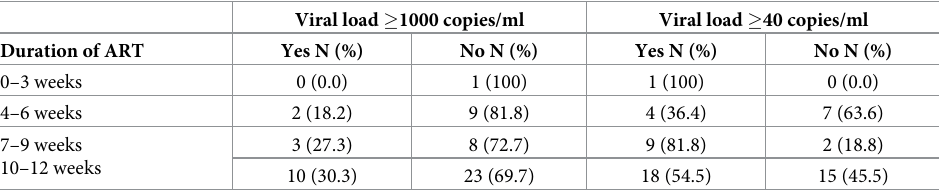
Table 3. Distribution of women who started ART (cid:20) 12